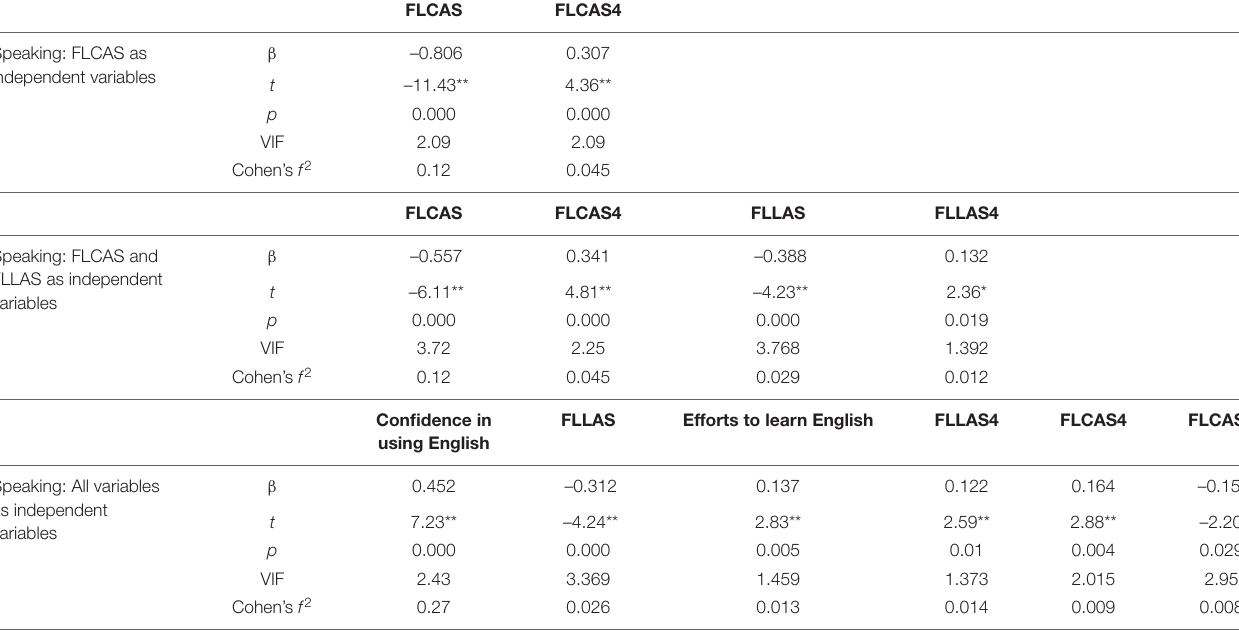
TABLE 4 | Multiple regression coefficients and significance of predictors for speaking English proficiency (phase